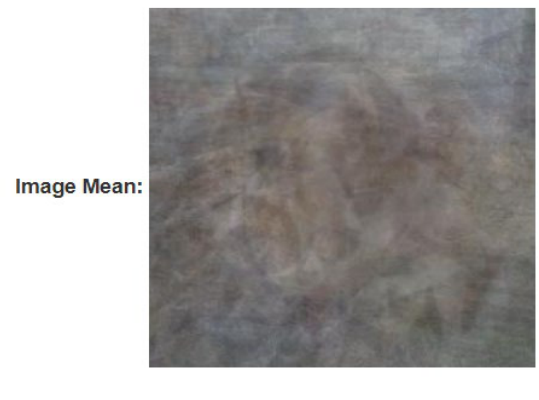
Figure 7. Image Mean